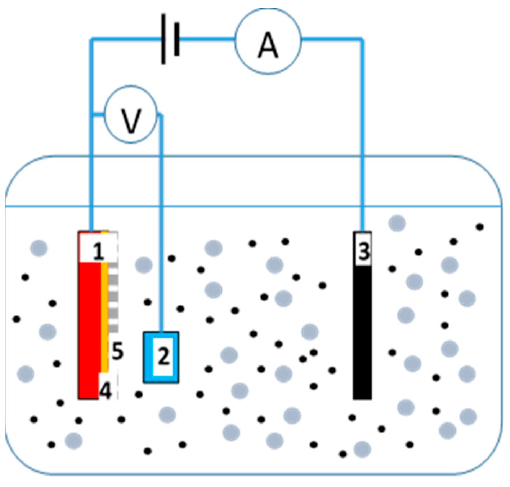
Figure 1. The electrochemical cell with a three-electrode system: 1—working electrode (cathode), 2—reference electrode, 3—counter electrode, 4—copper contact layer, 5—membrane.